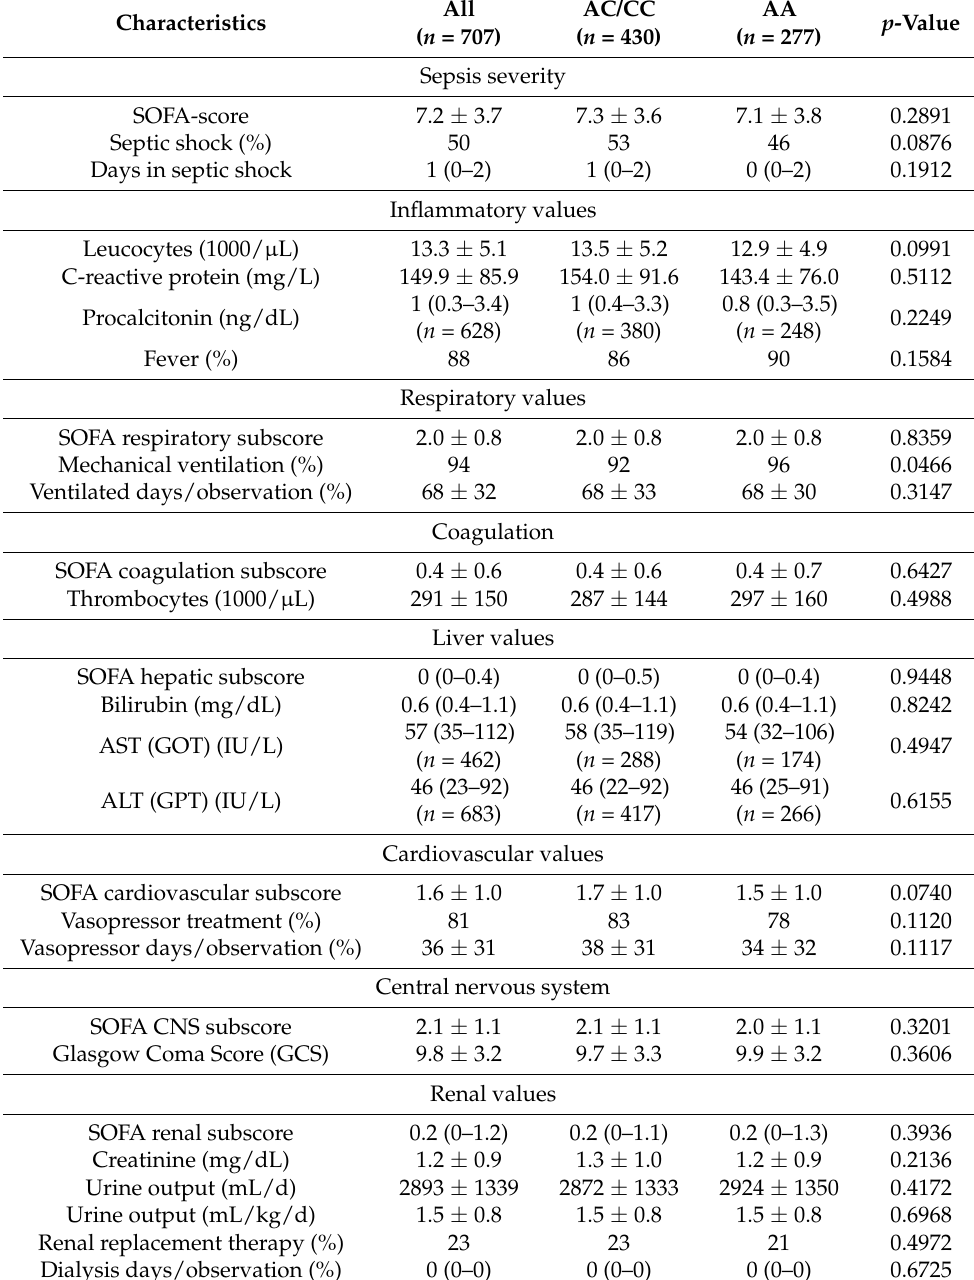
Table 2. Clinical parameters and disease severity analysis regarding LAG-3 rs951818 SNP.